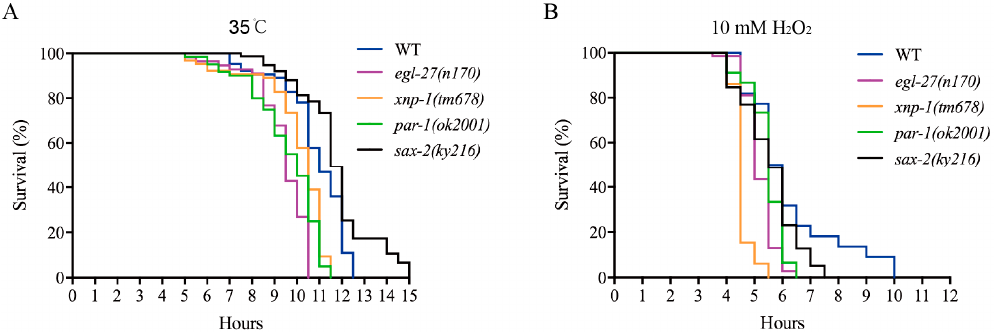
Figure 8. Temperature-responsive phosphoproteins are important regulators of the lifespan of C. elegans . (A) One-day-old egl-27 , xnp-1 , and par-1 mutants were less resistant to heat stress ( p < 0.01, log-rank test). One-day-old sax-2 mutants showed thermal resistance ( p < 0.01, log-rank test). (B) One-day-old egl-27 , xnp-1 , and par-1 mutants were shorter than wild-type strains under hydrogen peroxide treatment ( p < 0.01, log-rank test). One-day-old sax-2 mutants were shorter than wild-type strains under hydrogen peroxide treatment ( p < 0.05, log-rank test).